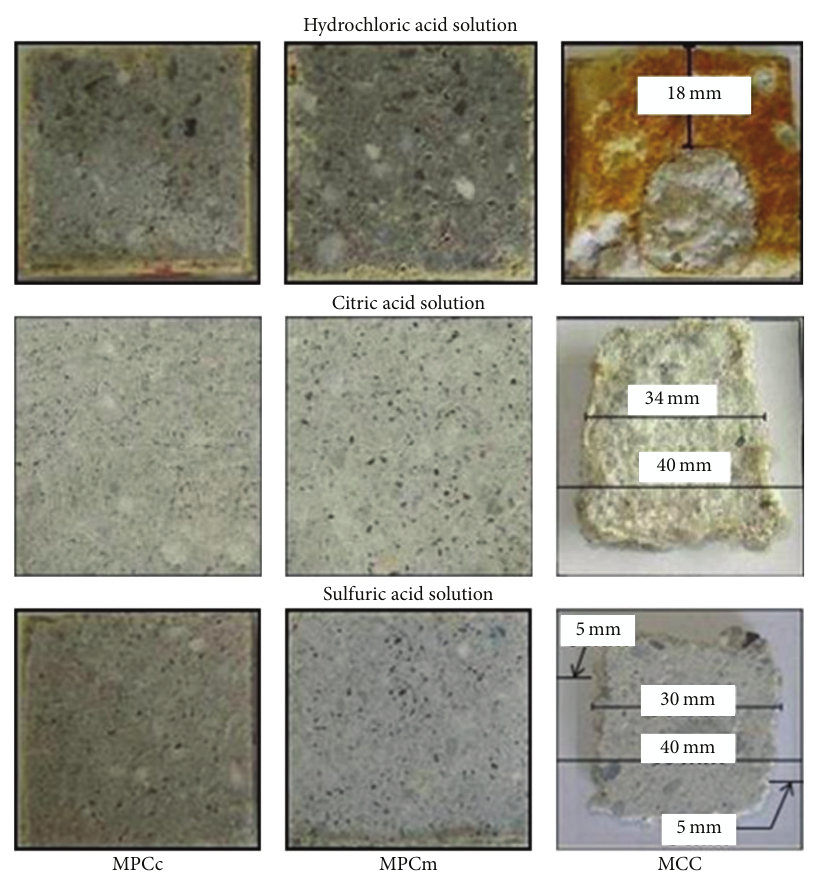
Figure 12: Visual degradation of the microconcretes after 60 days of immersion in acid